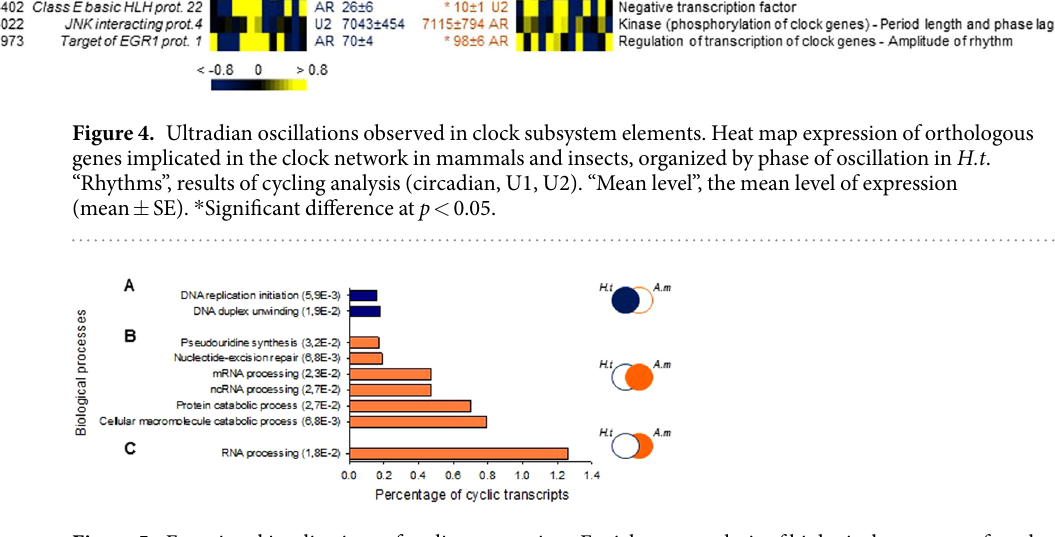
Figure 5. Functional implications of cycling transcripts. Enrichment analysis of biological processes of total cycling transcripts (circadian, U1, and U2) in H.t ( A ), in A.m ( B ), and uniquely in A.m ( C ). The ordinate axis shows the GO terms and significance (FDR) of enrichment while the abscissa axis shows the percentage of cycling for each GO